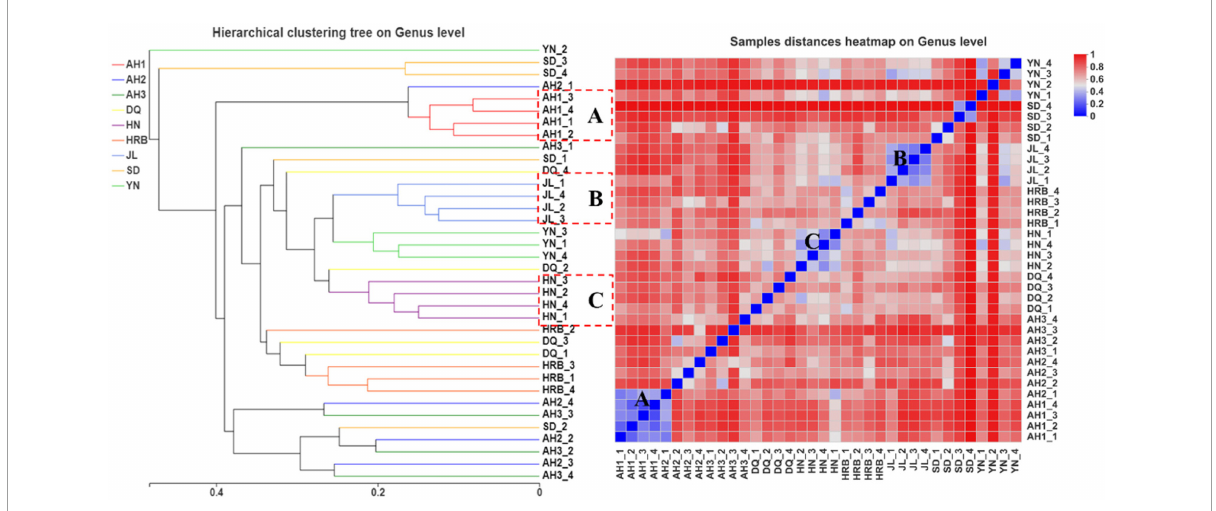
FIGURE8 UPGMA (left) and heatmap (right) analyses of the fungal community in the nine geographic populations of the hemp flea beetle P. attenuata in China.